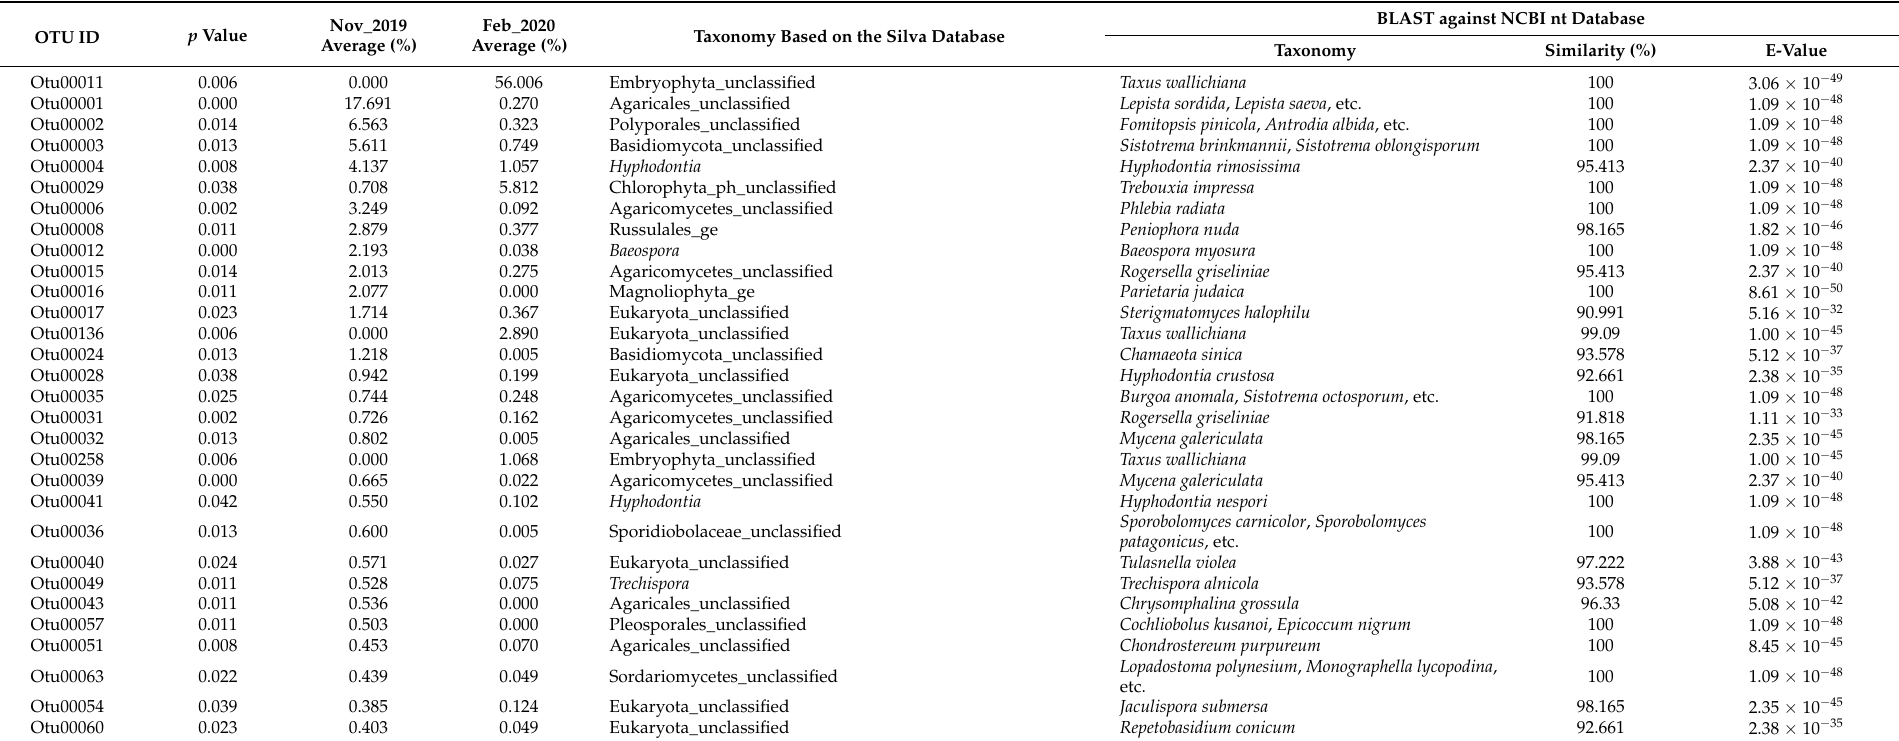
Table 4. t -test (or Wilcoxon test) results of the 30 most abundant eukaryotic OTUs that shows significant difference in their relative abundance between the November 2019 samples and the February 2020 samples. Their taxonomic annotation based on the Silva database and their BLAST result against NCBI nt database (best hit score, classified down to species level) are shown